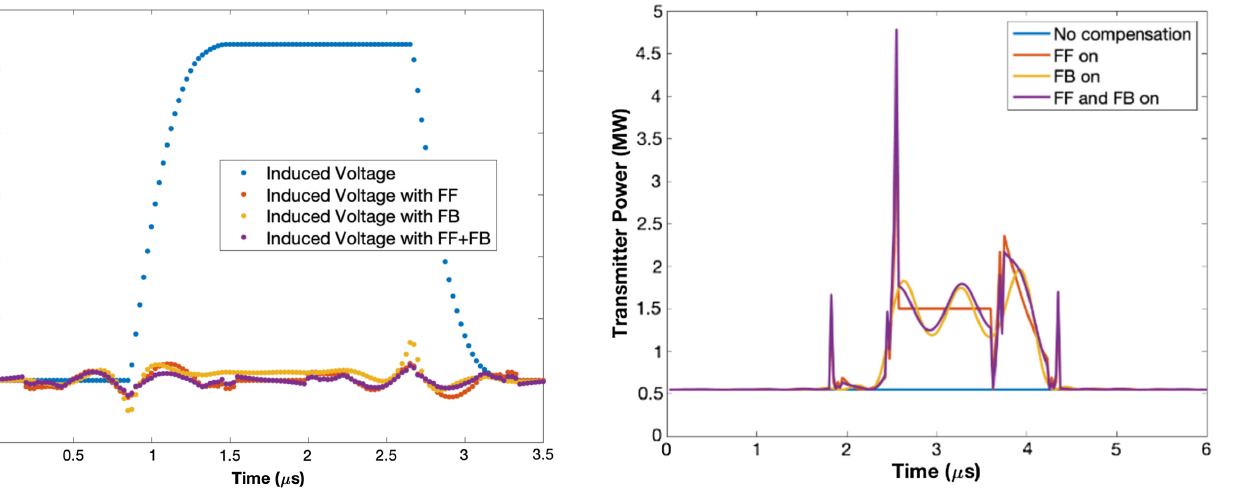
FIG. 7. Feedforward/feedback beam loading compensation. Total beam induced rf voltage from four three-section cavities and two four-section cavities.